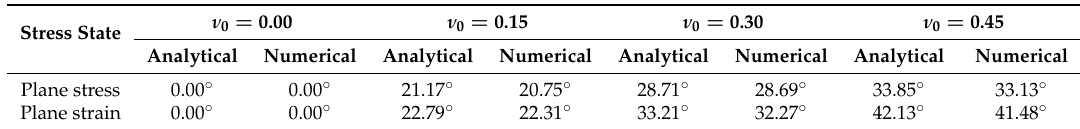
Table 1. Comparison between the analytically- and numerically-obtained discontinuity angles θ cr for the Simó and Ju [41] damage model.